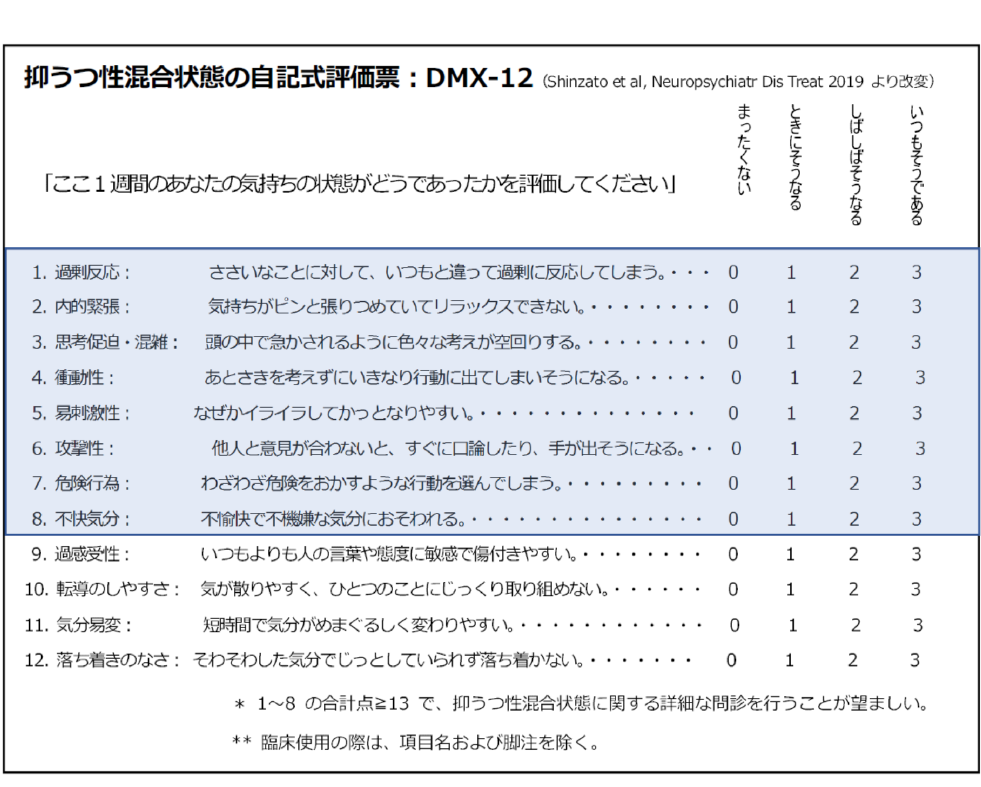
Figure A1. The 12-item questionnaire for quantification of depressive mixed state in Japanese.